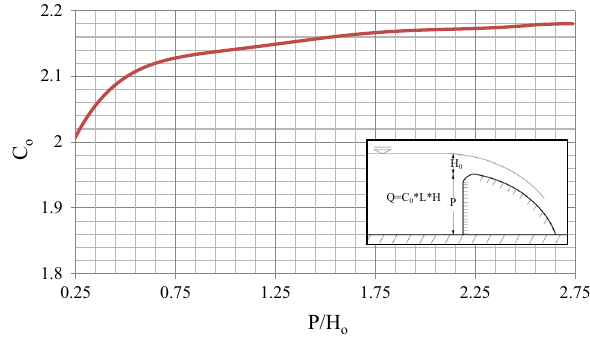
Fig. 2 Discharge coefficient for vertical-faced ogee spillway (USBR